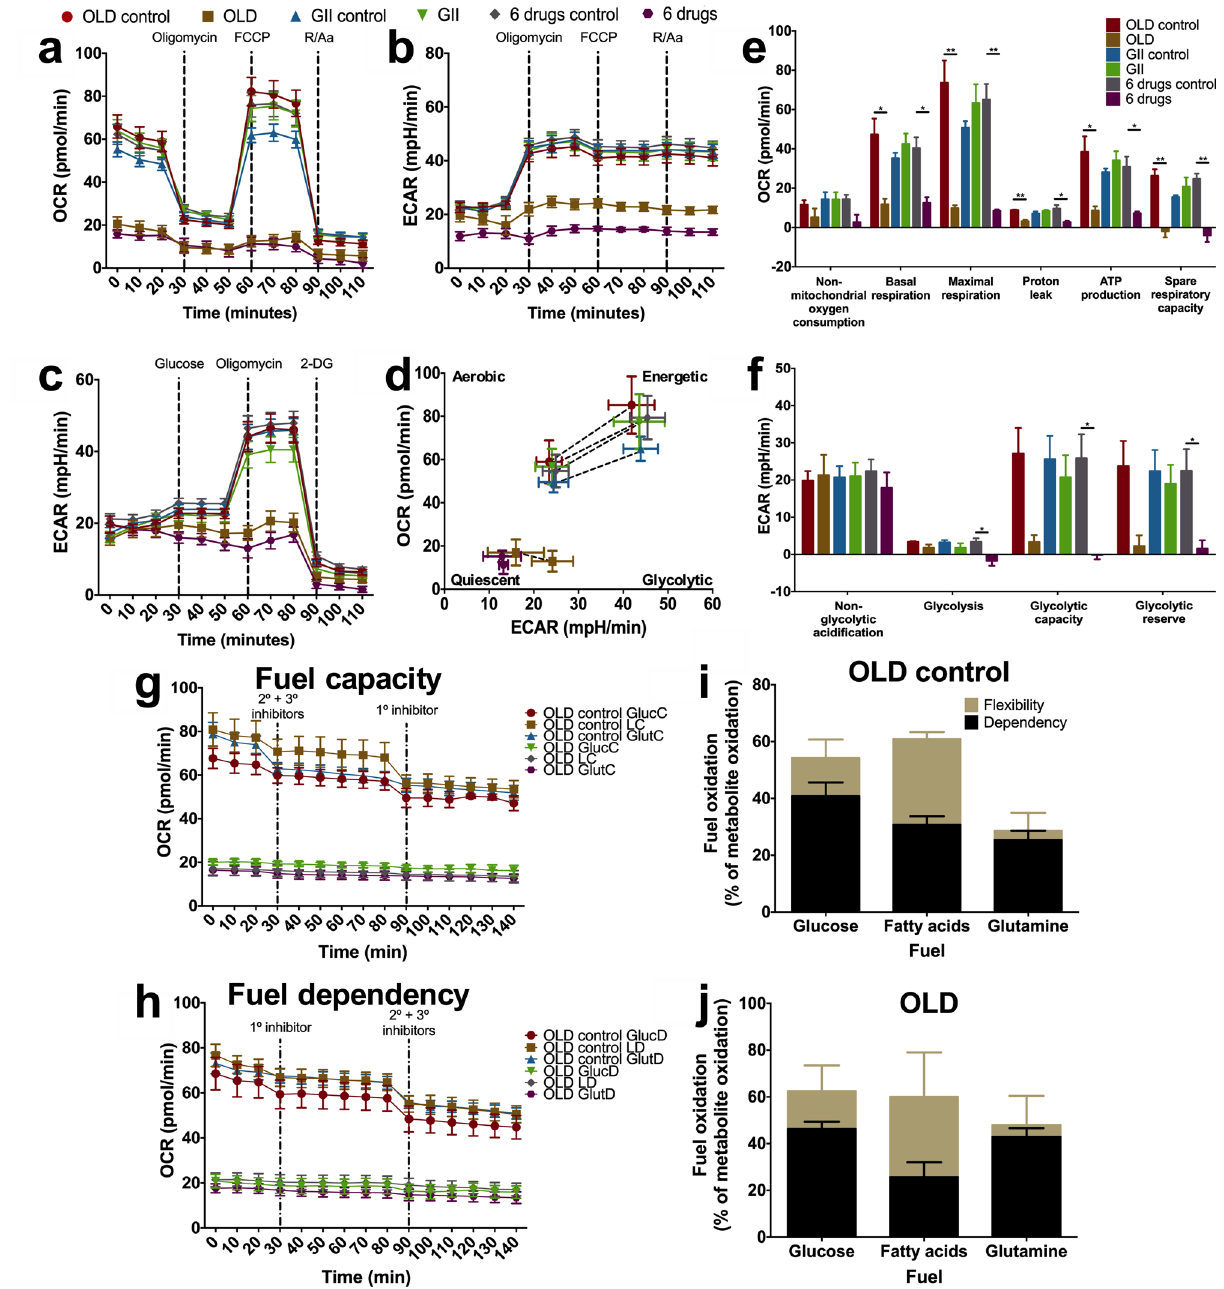
Figure 3. The triple energetic blockade alters the energetic machinery. Oxidative phosphorylation was evaluated by measuring OCR ( a ) and ECAR ( b ) prior to and after injecting oligomycin, FCCP, and a combination of rotenone (R) and antimycin A (Aa). ( c ) Glycolysis was evaluated by measuring ECAR prior to and after injecting glucose, oligomycin, and 2-deoxy-D-glucose (2-DG). ( d ) Energetic phenotype diagrams involving OCR and ECAR, under basal measurement and under the maximal stress after the injection of FCCP. ( e–f ) Individual parameters for oxidative phosphorylation ( e ) and for glycolysis ( f ). ( g-h ) Cellular respiration corresponding to substrate capacity ( g ) and dependency ( h ). ( i,j ) Fuel oxidation diagram representing the flexibility and dependency towards the three energetic substrates with OLD control ( i ) or OLD ( j ). The sum of flexibility and dependency indicates fuel capacity. Each condition was compared against its control. Data are expressed as means ± s.e.m. N = 3 independent experiments. Statistical analyses were performed with two- tailed unpaired Student t-test with Holm-Sidak correction. OLD: Orlistat + lonidamine + DON; GII: Growth hormone + insulin + indomethacin; 6 drugs: OLD + GII; GlucC: Glucose capacity; LC: Long-chain fatty acid capacity; GlutC: Glutamine capacity; GlucD: Glucose dependency; LD: Long-chain fatty acid dependency; GlutD: Glutamine Dependency; *p < 0.05 ; **p < 0.01